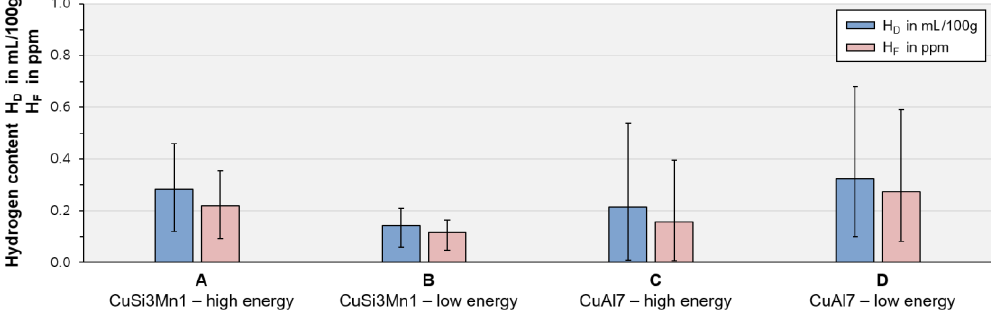
Figure 5. Hydrogen concentrations for GMAB using different filler metals and arc energies.